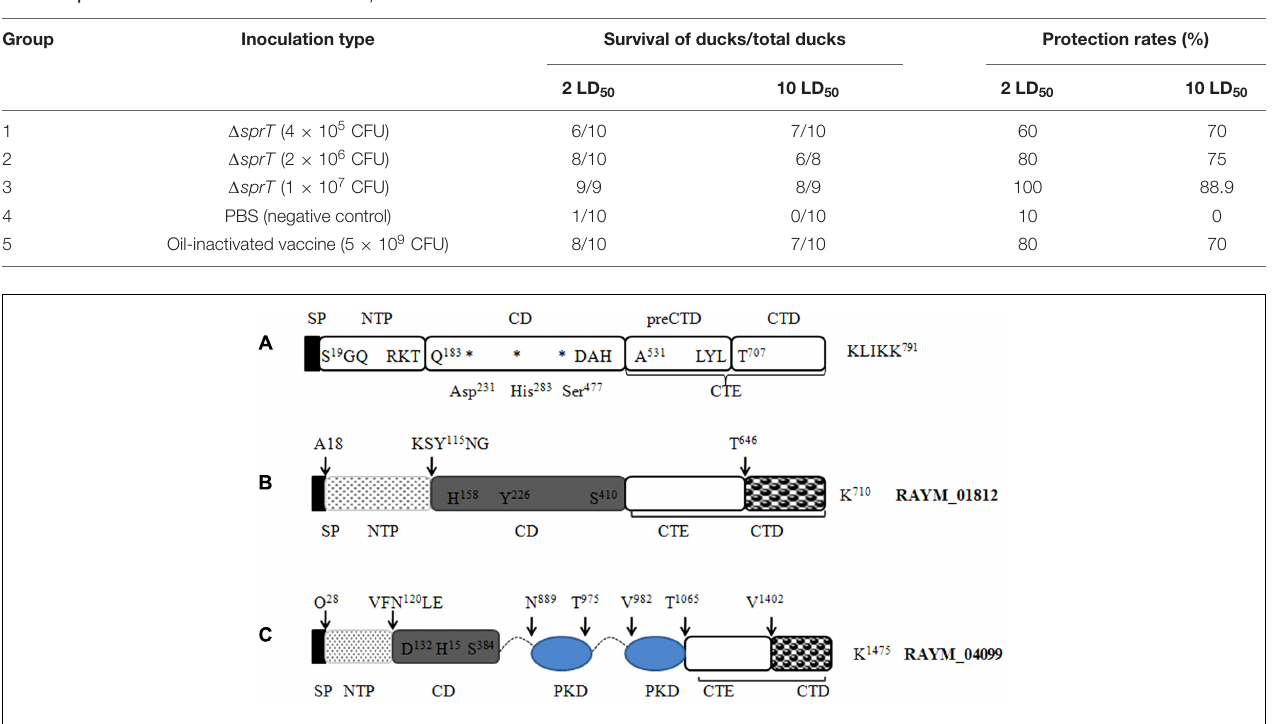
FIGURE 6 | Predicted protein domain structure of the S8 family of serine proteases in RA. Predicted structures of mirolase (A) (Ksiazek et al., 2015a), RAYM_01812 (B) , and RAYM_04099 (C) . Signal peptides were predicted using the Signal IP 3.0